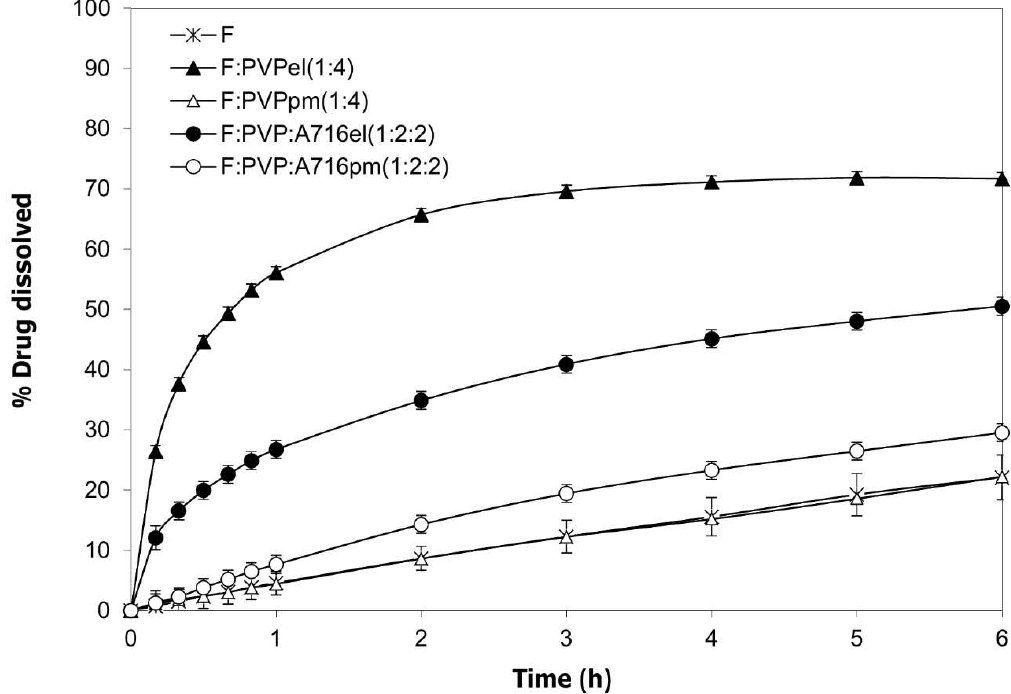
Figure 7. The dissolution profiles of the fibers made of PVP and F:PVPel (1:4) were compared to those obtained by combining PVP and hypromellose acetate succinate fibers, F:PVP:A716el (1:2:2), the